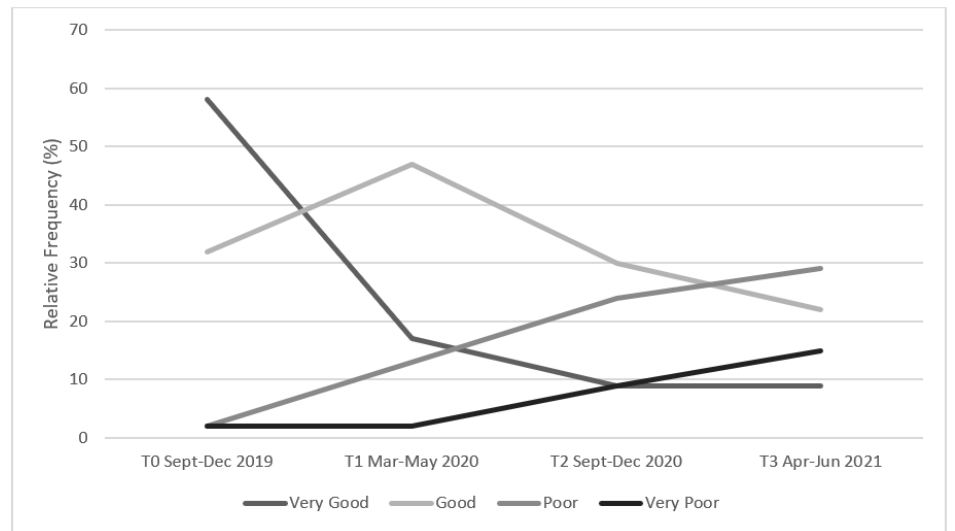
Figure 7. Percentage of participants who rated their university experience as ‘ Very Good ’ , ‘ Good ’ , ‘ Poor ’ and ‘ Very Poor ’ at four timepoints during COVID-19.